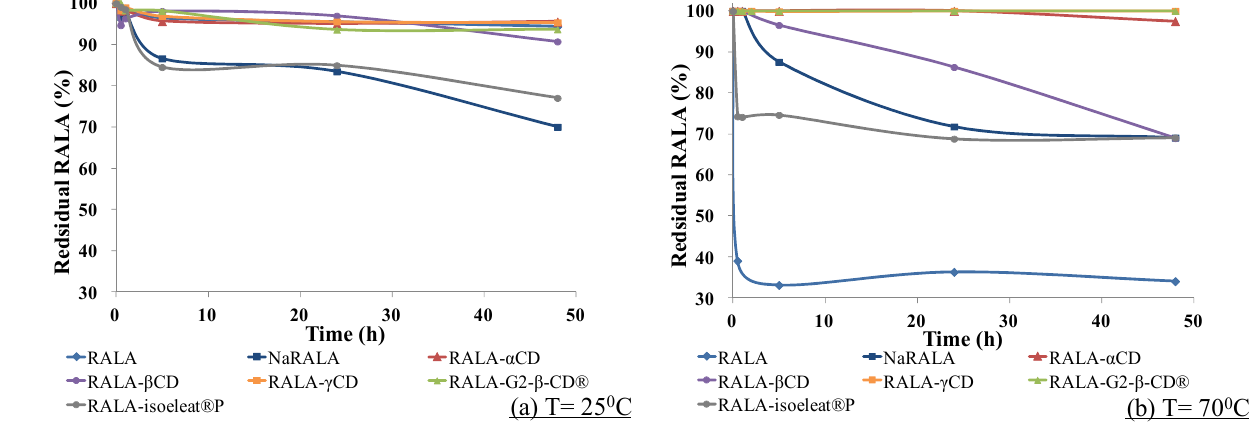
Figure 3. Stability of RALA complexes towards high temperatures. The samples were incubated at ( a ) 25 °C or ( b ) 70 °C and 100% relative humidity for 30 min, 1 h, 2 h, 5 h, 24 h and 48 h. The remaining amount of RALA was quantified using